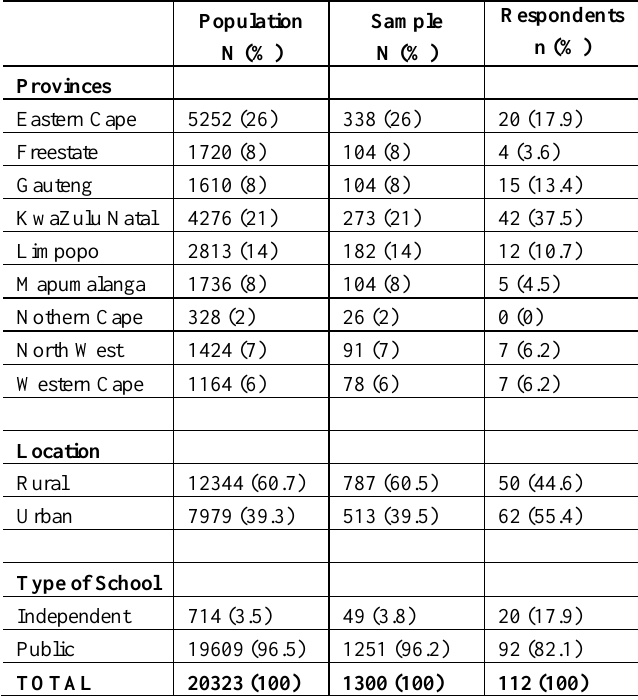
Table 2: A comparison of population parameters, sample Statistics and